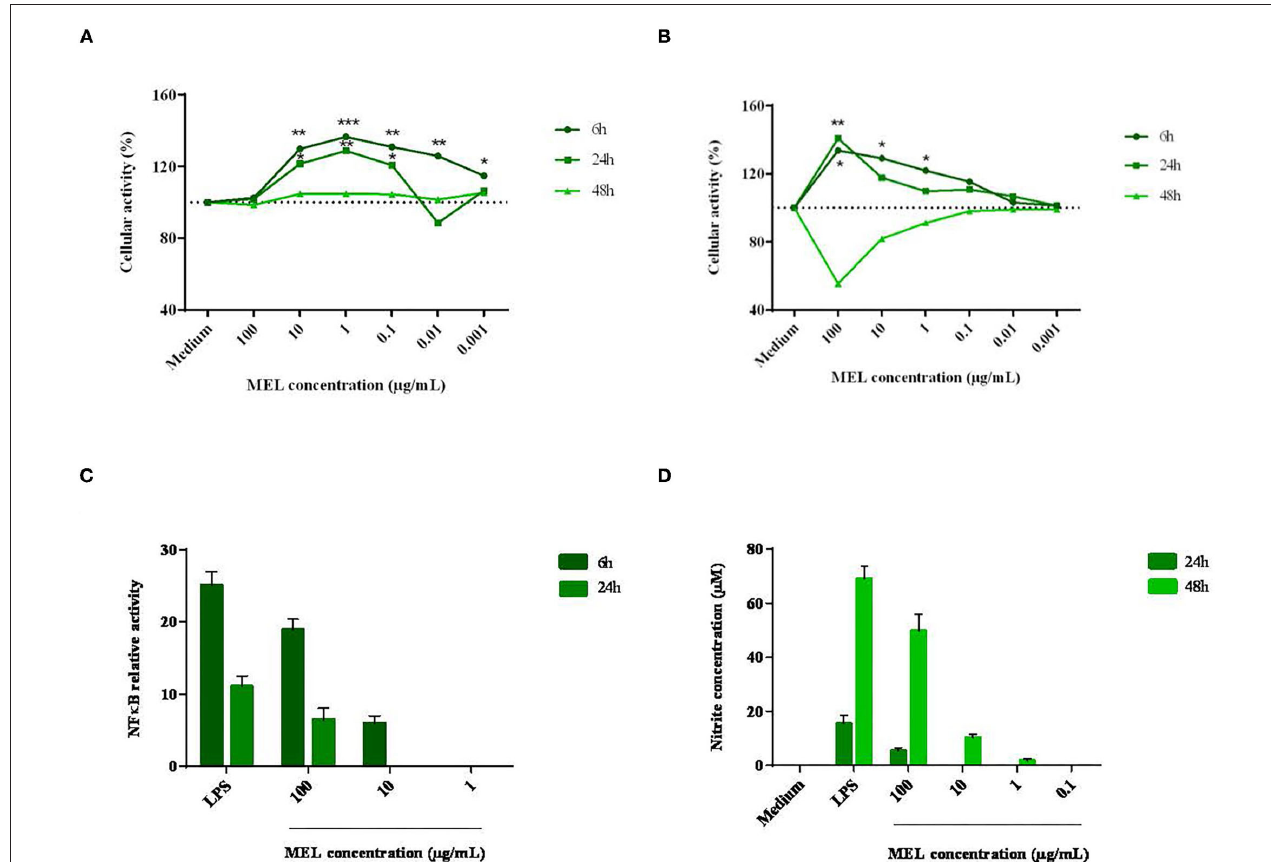
FIGURE 1 | Effects of different concentrations of MEL extract on the activity of hepatocytes (A) and macrophages (B) , the relative activity of NF κ B (C) and the nitrite concentration (D) after 6, 24 and 48h of incubation. These parameters were measured using a MTT assay, standard Griess assay and luciferase test, respectively, in comparison with the growing medium containing or not an essential component of the wall of Gram-negative bacteria: the LPS. The data shown are means ± SEM ( n = 3). Data were analyzed by ANOVA or with non-parametric Mann-Whitney